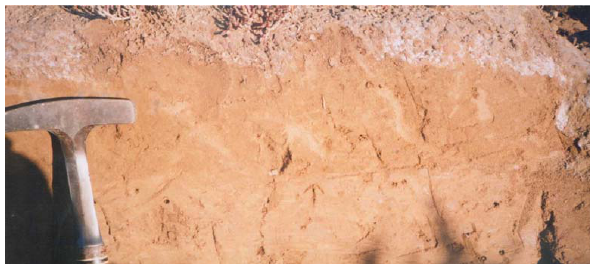
Fig. 6. Lithostratigraphy of Kirra in two trenches (T1 and T2) and five cores.